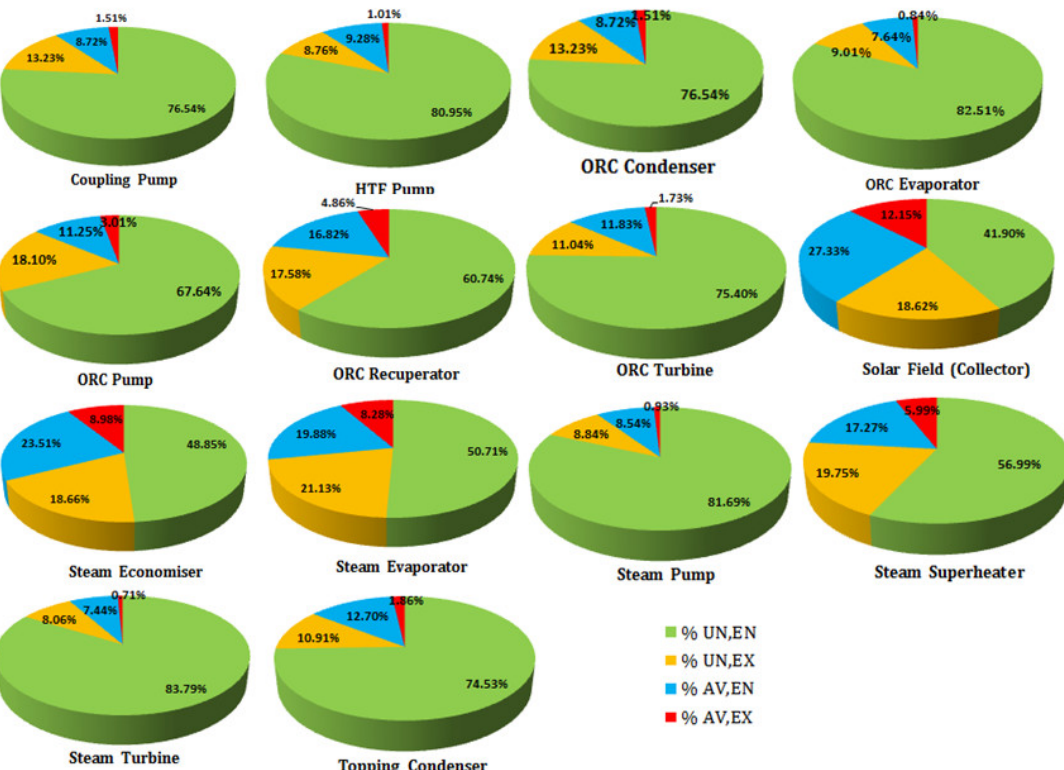
Appl. Sci. 2020 , 10 , x FOR PEER REVIEW Figure 4. Advanced exergy destruction rate of each component in the solar – geothermal cycle (SGPP). Figure 4. Advanced exergy destruction rate of each component in the solar–geothermal cycle (SGPP).